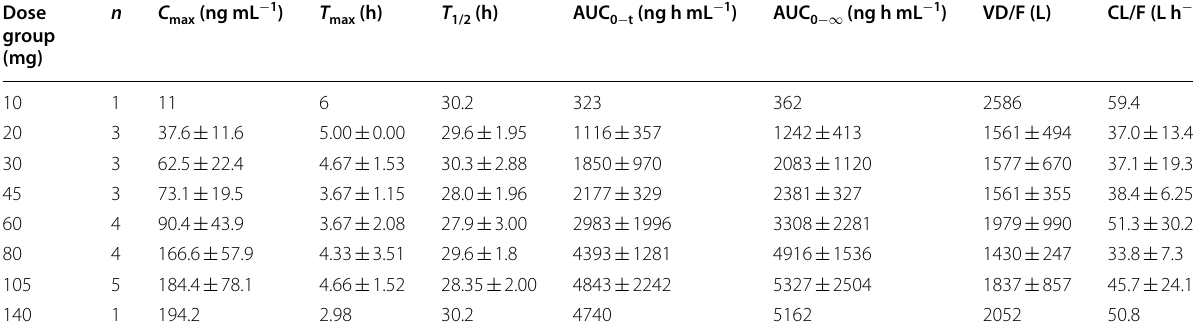
Table 4 The main PK parameters (Day 19) in NSCLC patients after a multiple oral dose of MET306 tablets at different doses Dose group (mg)